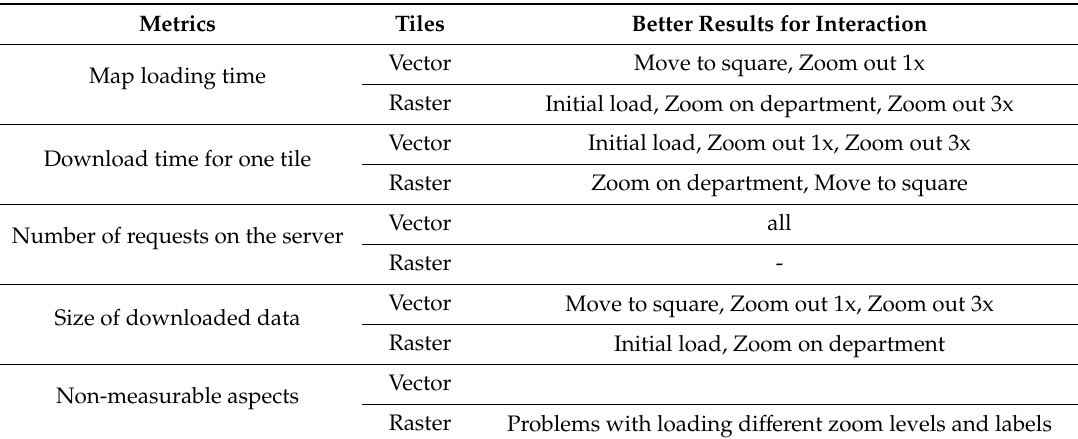
Table 4. Summary of the test